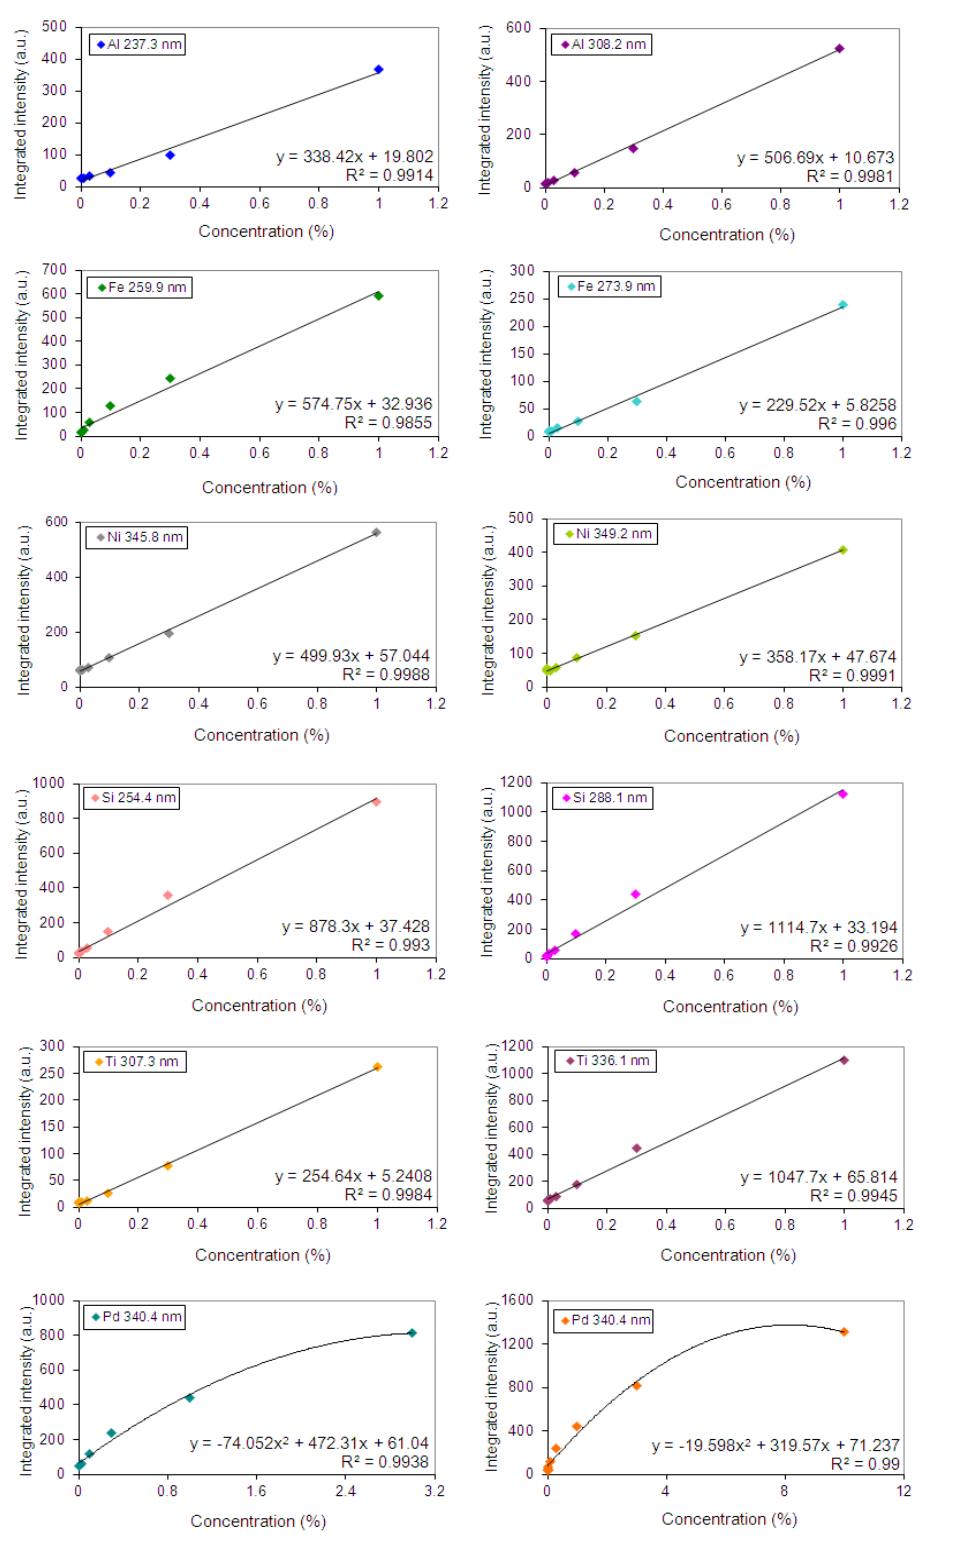
Figure 3. Analytical calibrations for trace elements (Al, Fe, Ni, Si, Ti); and active part of catalysts